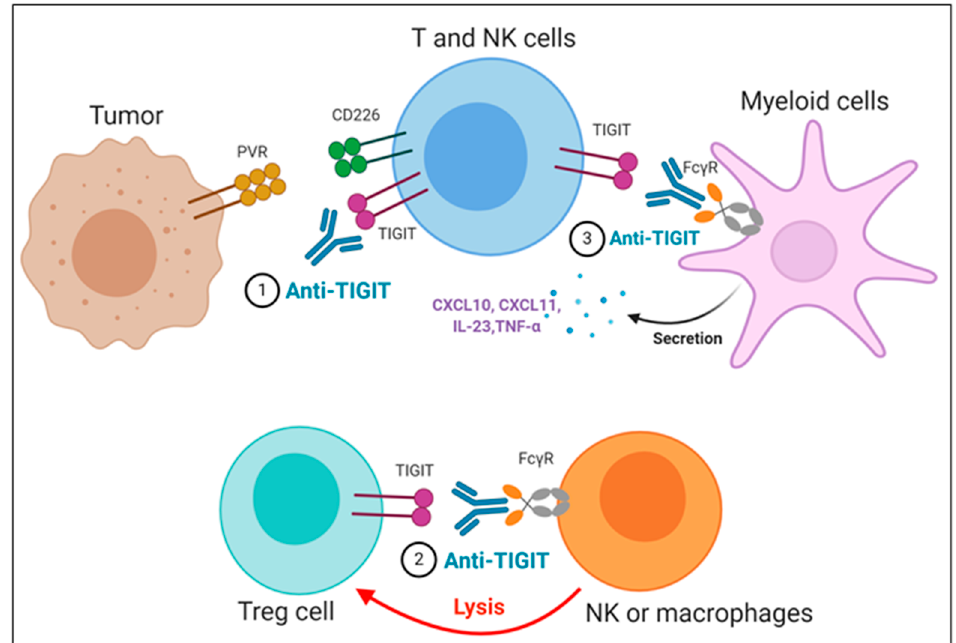
Figure 3. Proposed mechanisms of anti-TIGIT monoclonal antibodies (mAbs) in cancer immunotherapy. ( 1 ) Blockade of TIGIT could reverse the exhaustion of T and NK cell-mediated anti-tumor immunity. ( 2 ) Intratumoral regulatory T cells (T reg_ ) cells expressing high levels of TIGIT could be preferentially depleted by anti-TIGIT mAbs, presumably through antibody-dependent cellular phagocytosis (ADCP) by macrophages and/or antibody-dependent cellular cytotoxicity (ADCC) by NK cells. ( 3 ) The TIGIT mAb- fragment crystallizable (Fc) gamma receptors (Fc γ R) engagement could activate myeloid cells, leading to enhanced antigen presentation function and proinflammatory chemokine and cytokine secretion.